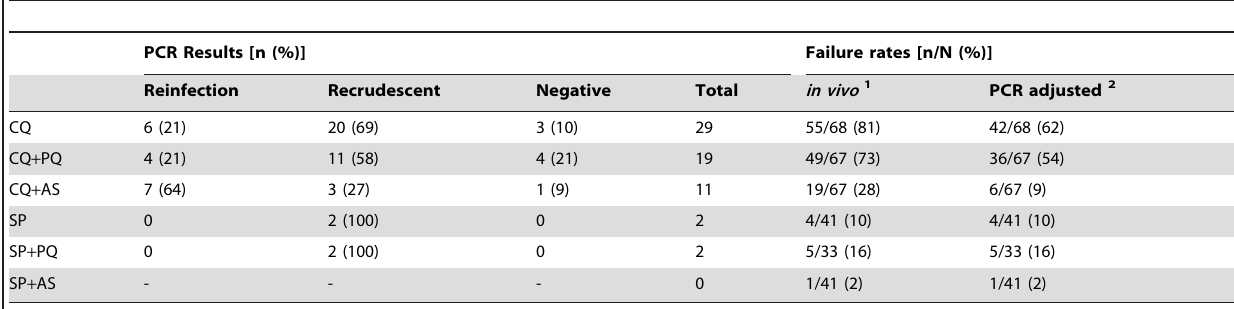
Table 5. Outcomes of PCR analysis, and projected adjusted failure rates by treatment group excluding indeterminate